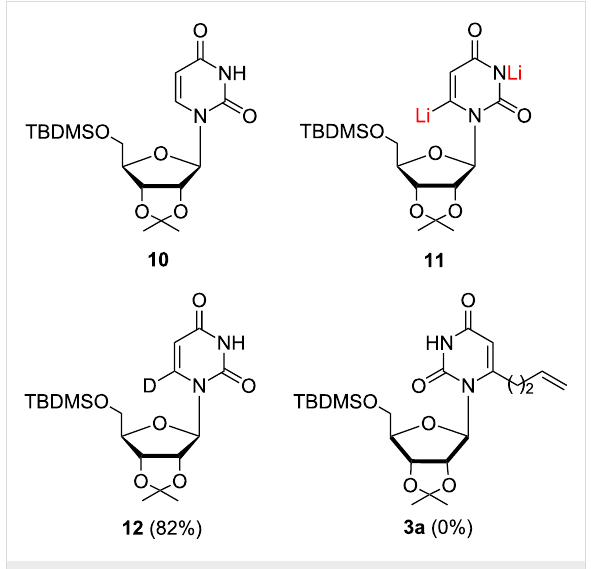
Figure 2: Metalation of 5'- O -TMDMS protected nucleoside 10